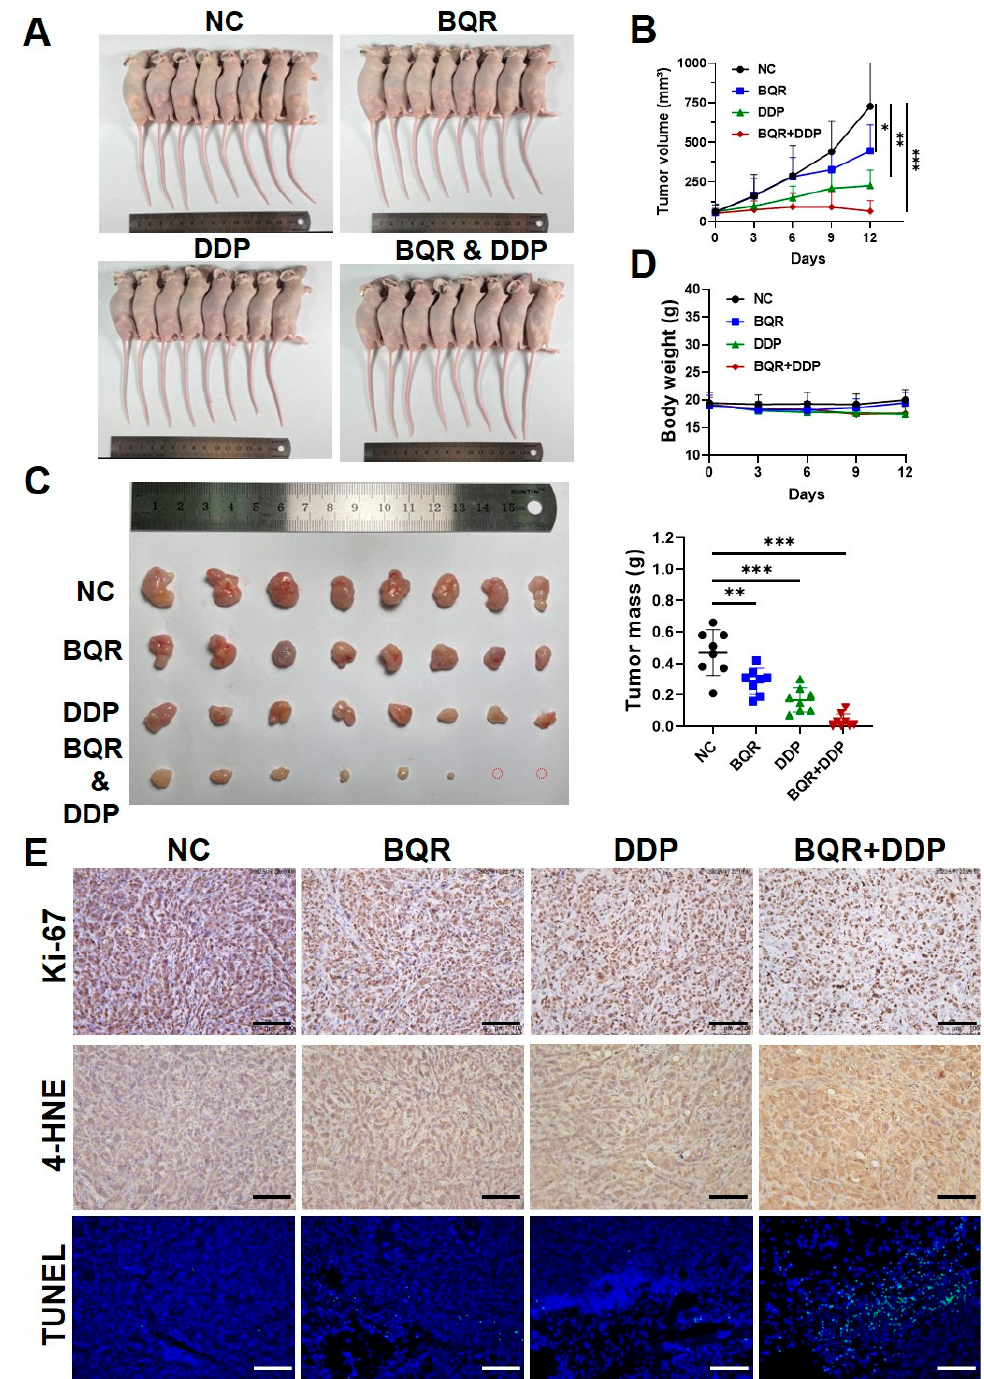
Figure 4. Brequinar (BQR) synergizes with cisplatin (DDP) to inhibit the growth of cervical cancer cells in vivo. ( A ) Images of nude mice with subcutaneous tumor injected by HeLa cells. Groups of mice were treated with BQR (15 mg/kg) and/or DDP (7 mg/kg) as indicated ( n = 8 per group). ( B ) Growth curves of HeLa tumors of each group. * p < 0.05, ** p < 0.01, *** p < 0.001 compared to the control group. ( C ) Images of resected tumors from each group, and tumor mass of HeLa tumors of each group. ** p < 0.01, *** p < 0.001 compared to the control group. ( D ) Body weight of nude mice in each group. ( E ) Representative images of IHC staining for Ki-67 and 4-HNE, and representative images of TUNEL staining from sections of xenografted tumors. Scale bar = 250 μ m.